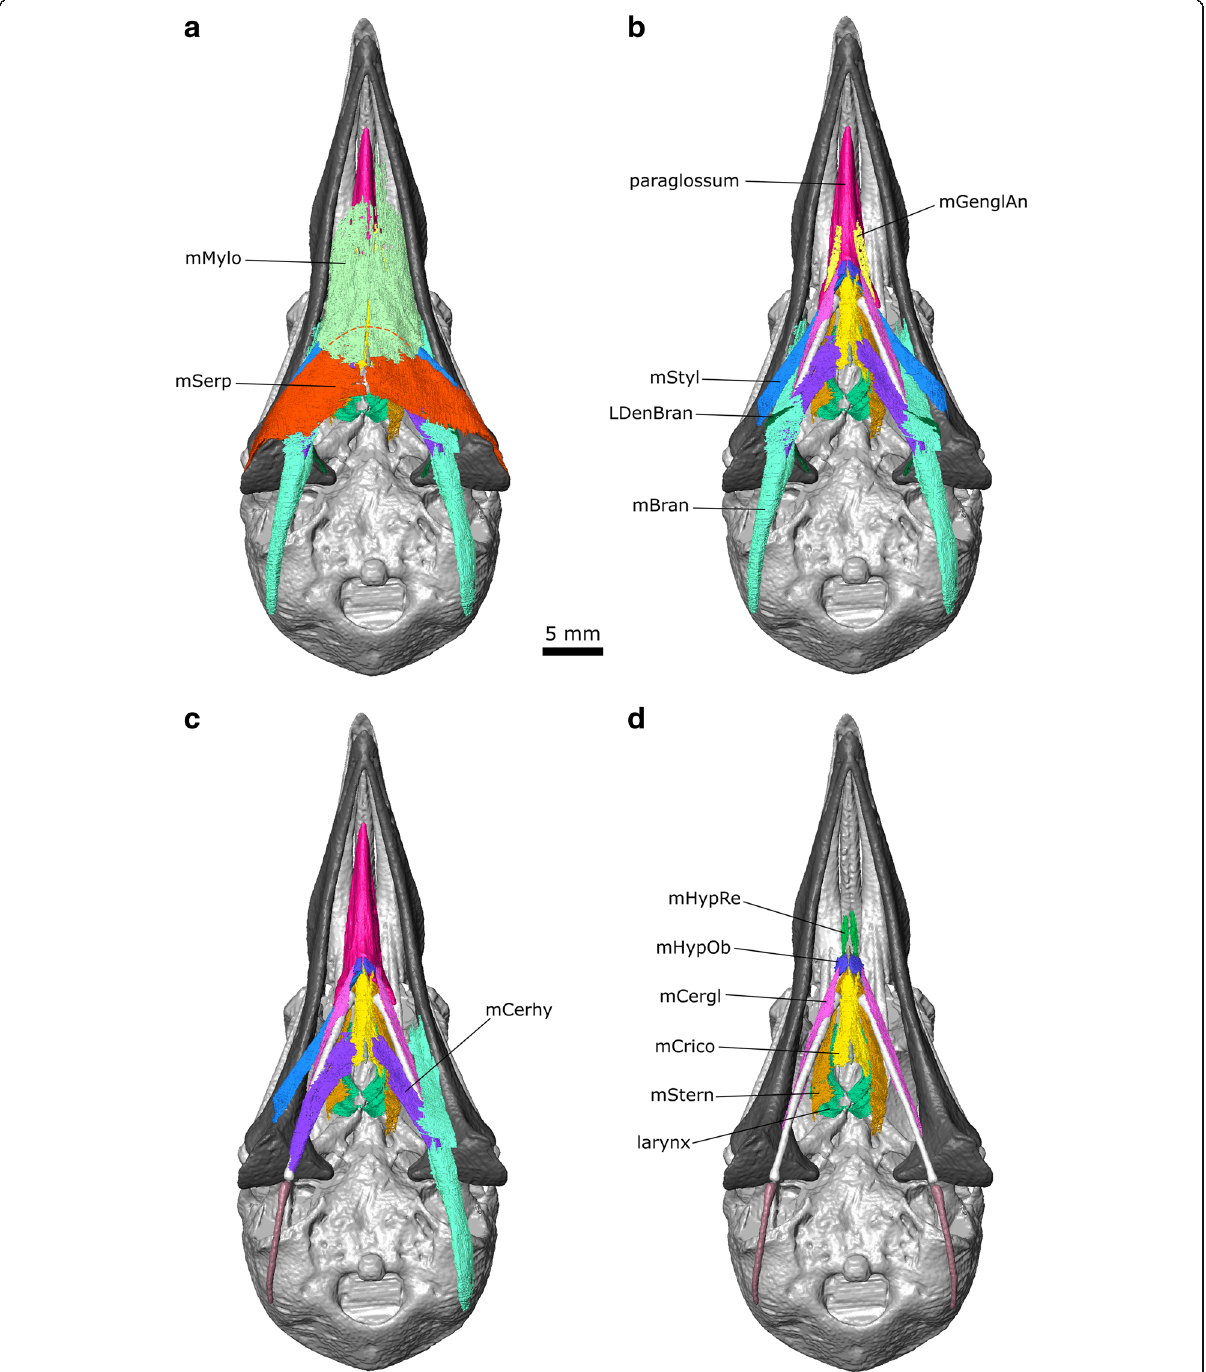
Fig. 12 The throat muscles of Columba livia in ventral view. a to d represent increasingly deep